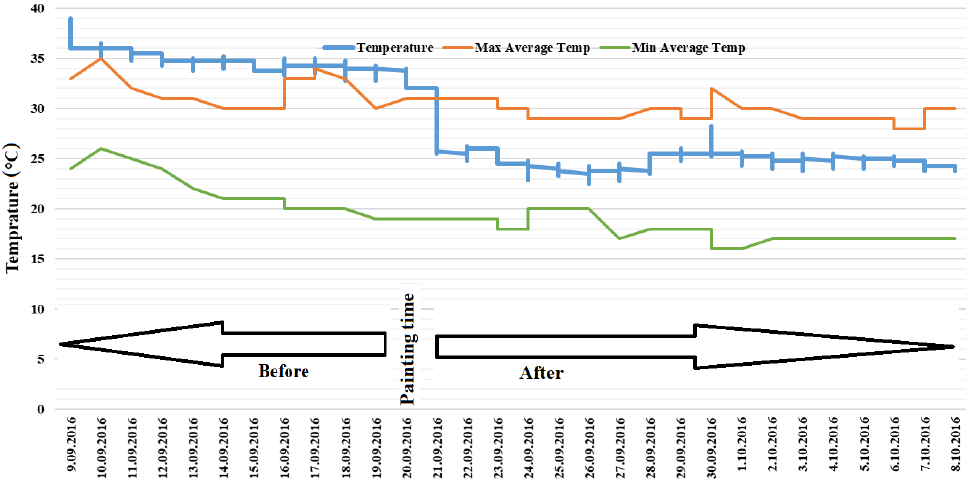
Figure 10. Measurement values of daily average and maximum/minimum temperatures for TR4.